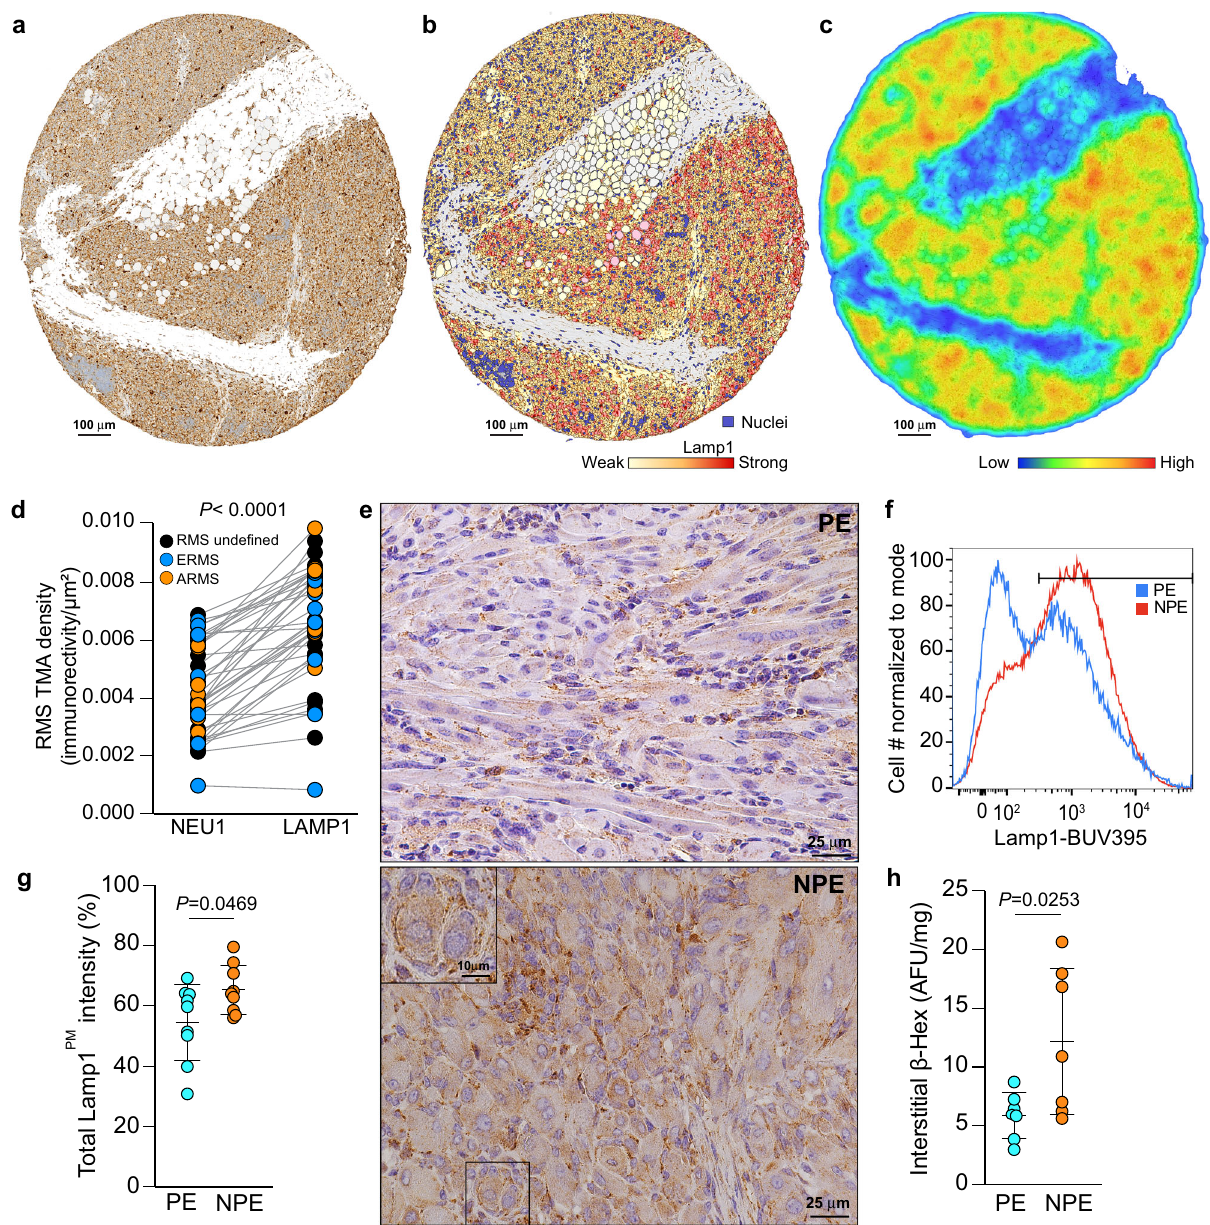
Fig. 3 LAMP1 redistribution at the plasma membrane is a readout for increased lysosomal exocytosis downstream of low NEU1 expression. a Representative core of human RMS TMAs immunostained for LAMP1. Scale bar: 100 µ m. b Density map of algorithm applied to a LAMP1-stained core showing LAMP1 PM minimal and maximum density and location. Scale bar: 100 µ m. c Heatmap representing the intensity of LAMP1 PM staining of the core shown in a. Scale bar: 100 µ m. d Correlation between low NEU1 and high LAMP1 PM immunoreactivity in paired cores of human RMS TMAs. Two TMAs were used; Paired t- test; n = 41 biologically independent samples. e Representative micrographs of increased Lamp1 immunostaining in NPE compared with PE RMS. Punctuated lysosomal staining, typical for Lamp1. Scale bar: 25 µ m, inset scale bar: 10 µ m. f Flow cytometry histogram showing higher Lamp1 PMpos expression in cells in NPE RMS versus PE RMS. g Increased Lamp1 PM intensity quanti fi ed by fl ow cytometry in NPE versus PE RMS. Mean± s.d.; Paired t- test; n = 9 biologically independent tumors. h Increased β -hexosaminidase activity in the interstitial fl uid from NPE versus PE RMS. Mean± s.d.; Student ’ s (unpaired) t -test; n = 7 biologically independent